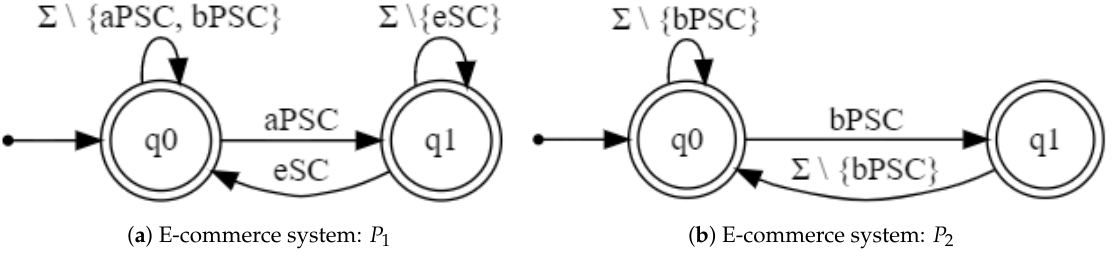
Figure 7. E-commerce system: Automata of the analyzed requirements.